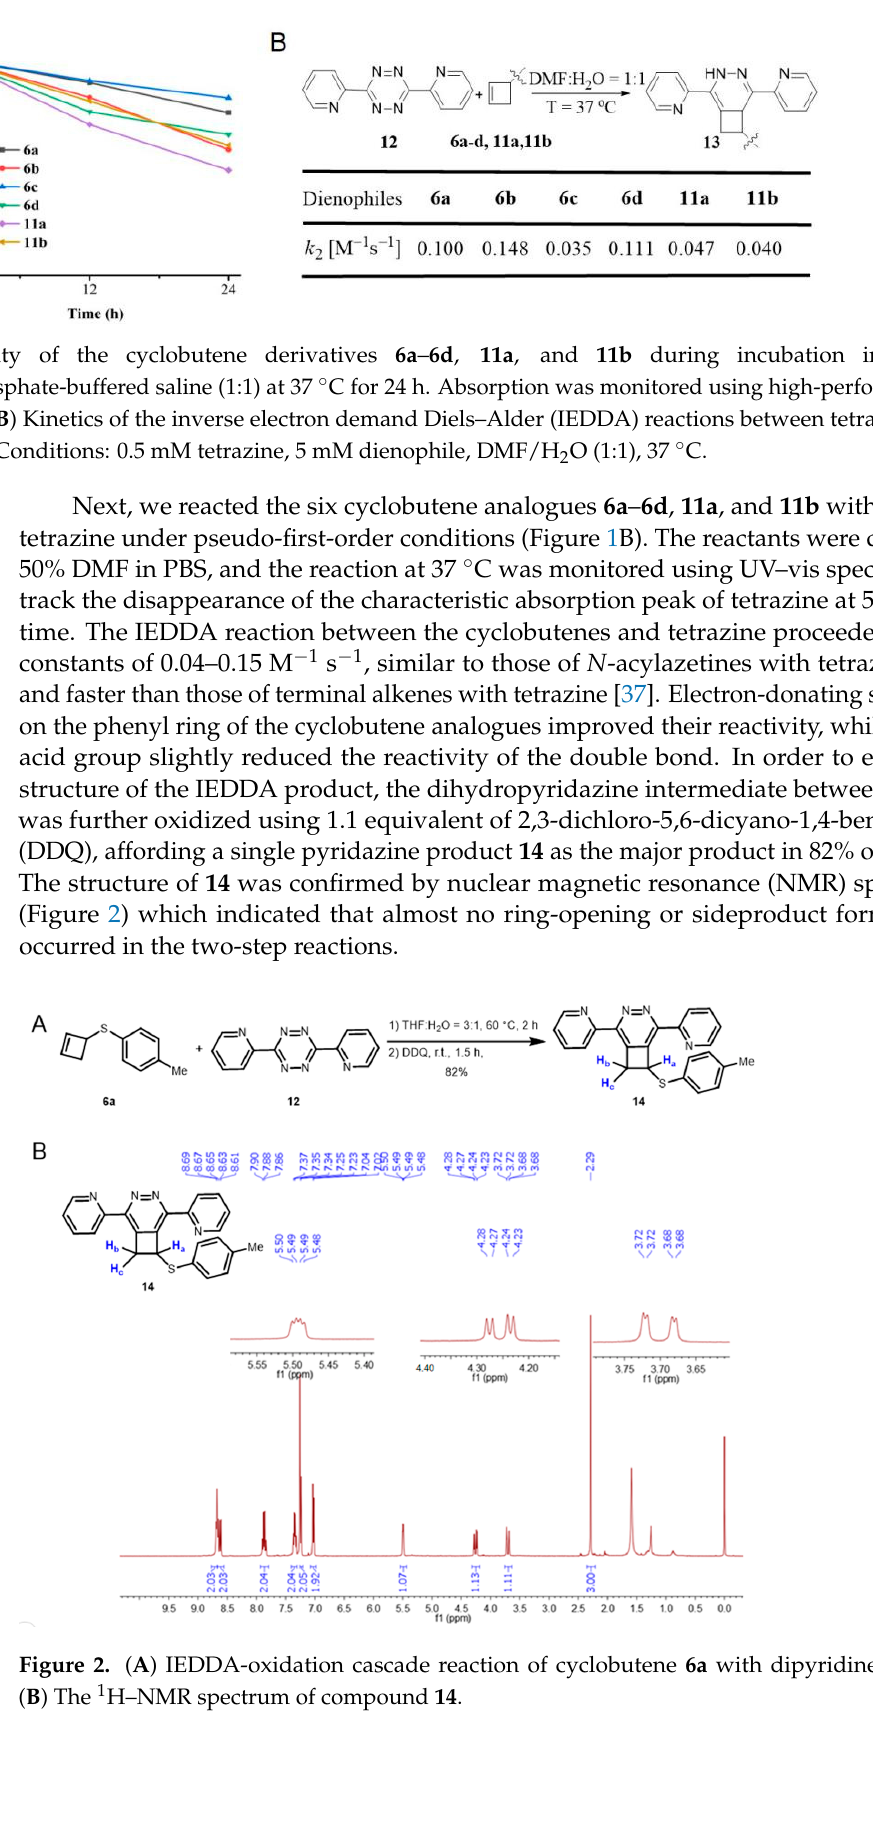
Figure 2. ( A ) IEDDA-oxidation cascade reaction of cyclobutene 6a with dipyridinetetrazine 12 . ( B ) The 1 H–NMR spectrum of compound 14 .